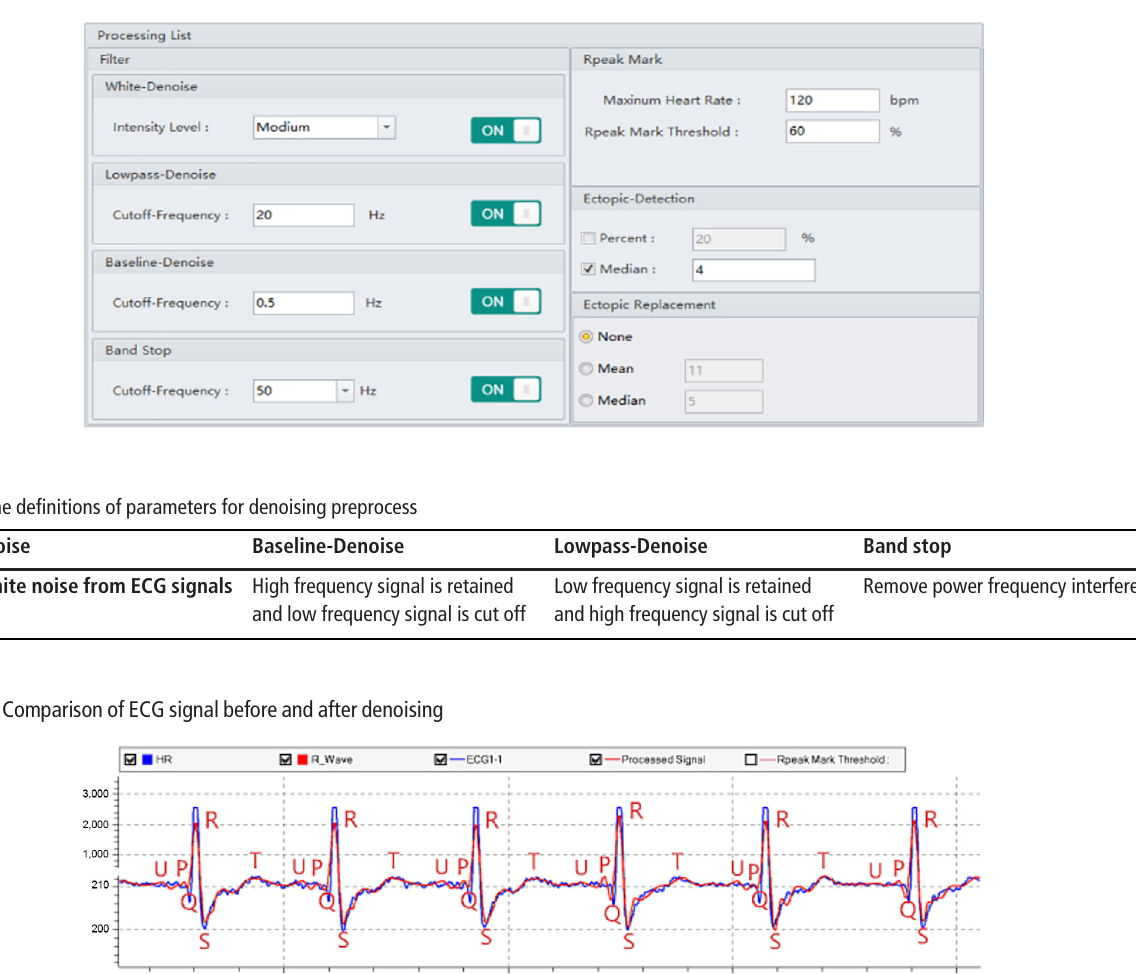
Figure 10 Denoising preprocess interface for original ECG signal